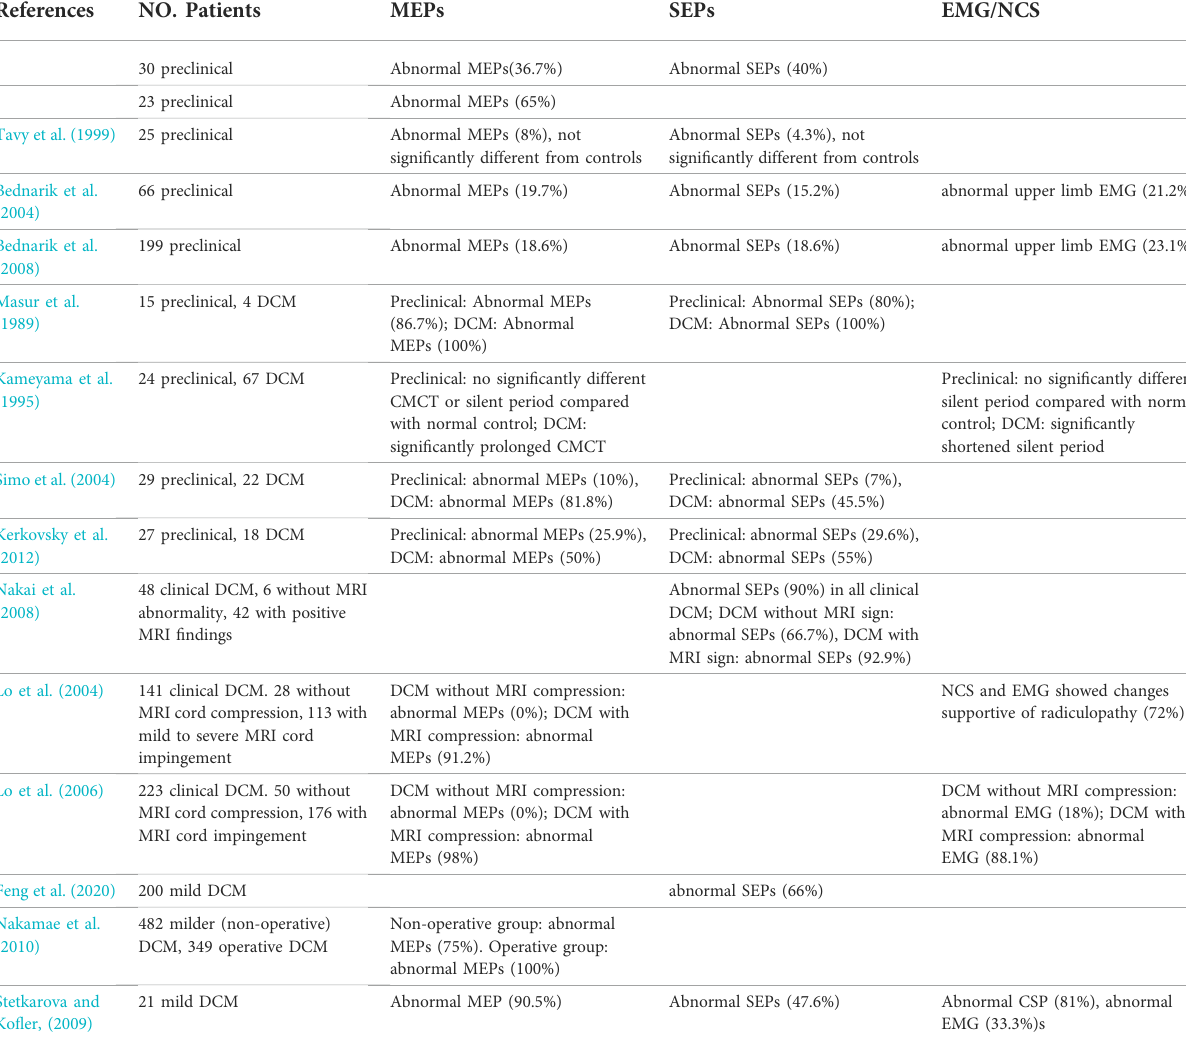
TABLE 1 Diagnostic sensitivity of neurophysiological tests for preclinical or mild